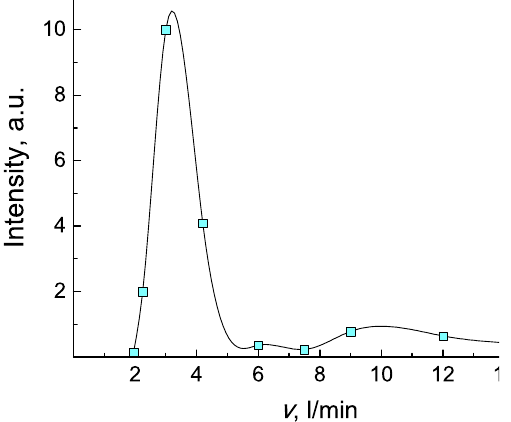
Figure 7. Intensity of OH-peak at λ = 309 nm in helium for different gas flow rates with the grounded substrate, U = 4.9